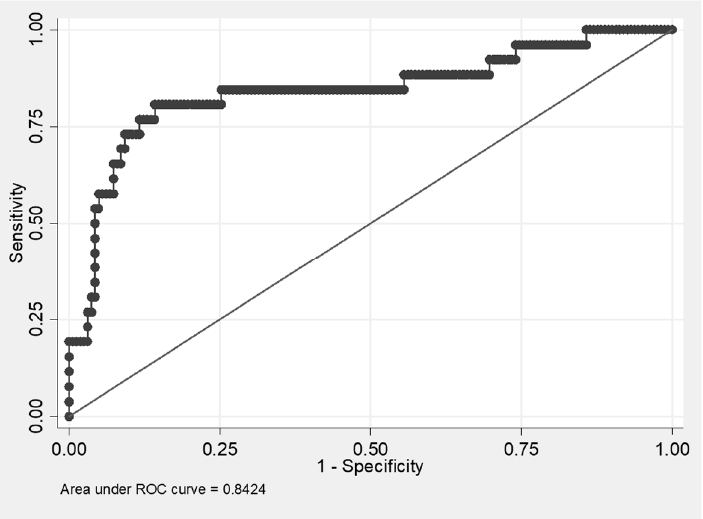
Figure 5. ROC curve of CX3CL1/ADAM17 predictive ability to discriminate IPF (idiopathic pulmo- nary fibrosis) from other diffuse parenchymal lung diseases. Youden’s index = 0.6657; the cut off value of CX3CL1/ADAM17 ratio associated with the highest value of Youden’s index is CX3CL1/ ADAM17 =41.668; sensitivity = 0.8077; specificity = 0.8580. CX3CL1/ADAM17 =41.668; sensitivity = 0.8077; specificity =